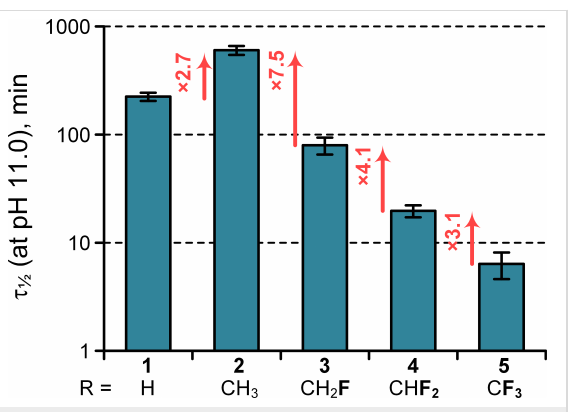
Figure 2: Kinetics of the C-terminal ester hydrolysis.